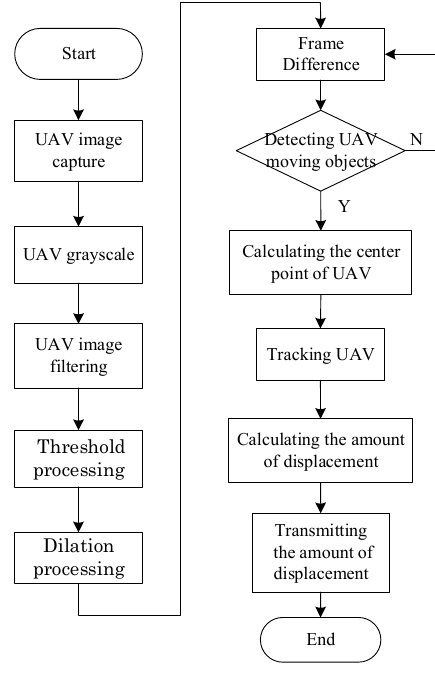
Figure 2. Drone image tracing flowchart.